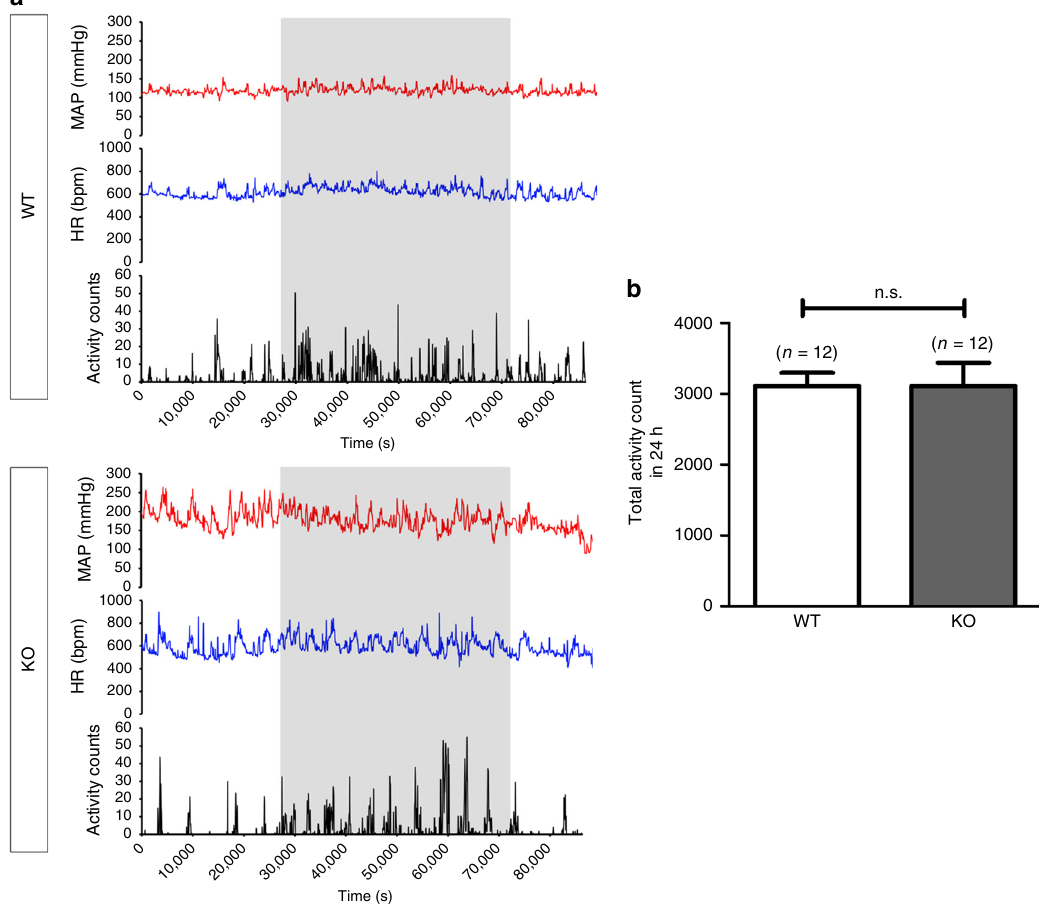
Fig. 2 Freely moving conscious wild-type and Trpc5 − / − mice show similar locomotion activity. a Representative traces for 24 h recording of mean blood pressure, heart rate and locomotion activity count in 1 min time interval in a wild-type mouse (upper) and a Trpc5 − / − (lower) mouse measured by telemetry. Shaded regions represent the night time from 1800 hours to 0600 hours of the next day, in which the animals were more active. b Summarized data showing the total activity count in 24 h. Mean ± s.e.m. n = 12. n.s. (not signi fi cant, P > 0.05). Statistical analysis was performed